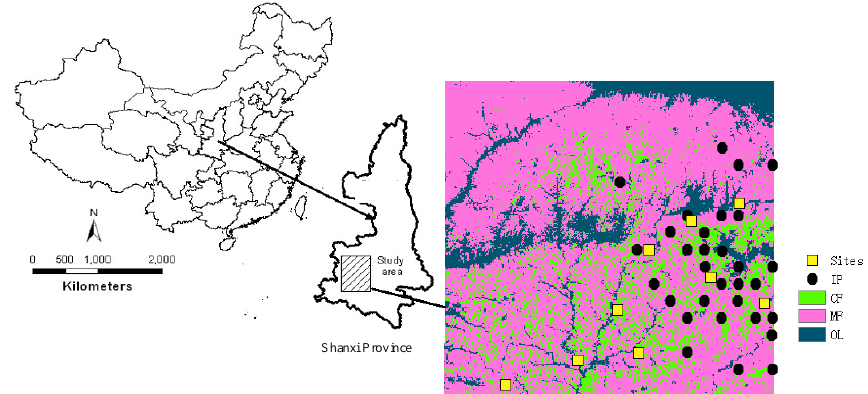
Fig. 2. Study area with the locations of ground sites in Qinling Mountain in southern Shanxi Province in China.